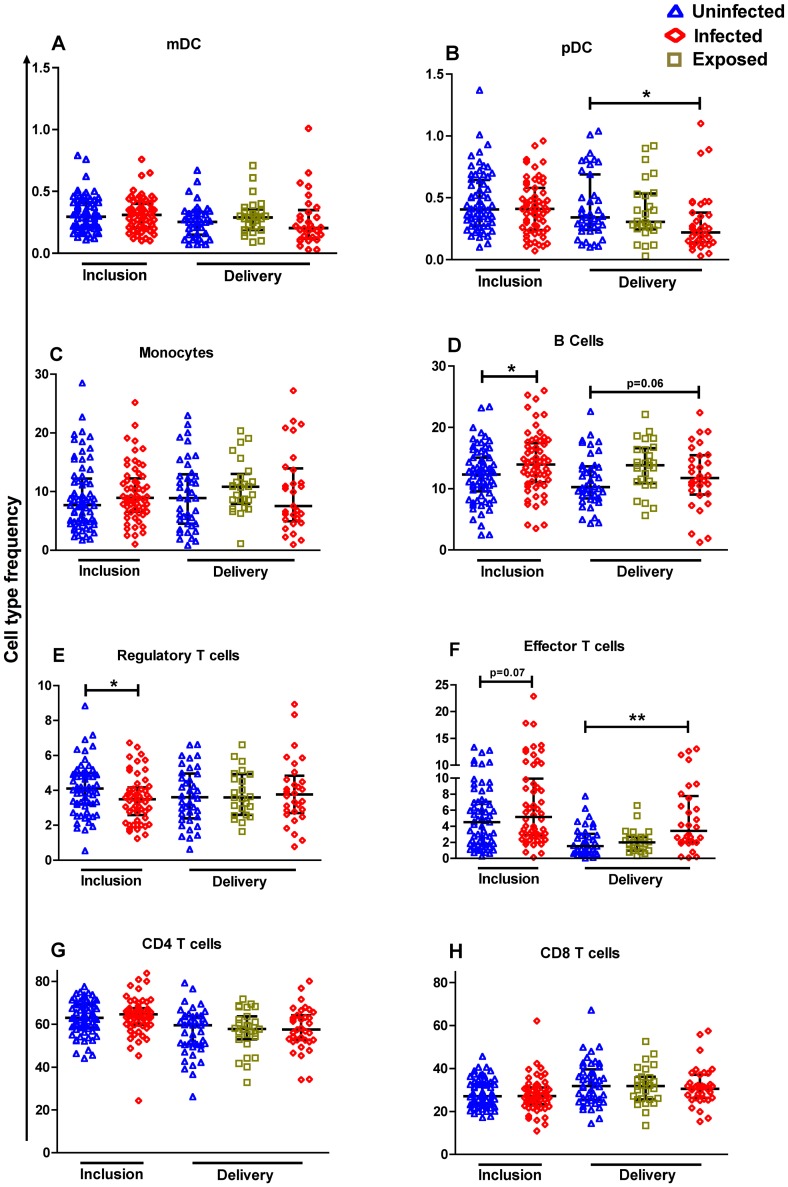

P. falciparum infection-related changes in peripheral blood mononuclear cell frequencies of pregnant Beninese at inclusion and at delivery.Scatter plots include bars depicting medians with interquartile ranges of antigen-presenting cells (A, B, C and D) and T cell subset frequencies (E, F, G and H) from 69 uninfected compared to 62 infected women at inclusion, and from 47 uninfected, 27 exposed and 37 infected women at delivery. The statistical significance of differences between profiles segregated according to the presence or absence of infection were determined using the non-parametric Mann Whitney U test for data at inclusion combined with the non-parametric Kruskall Wallis test for data at delivery. *p<0.05, **p<0.01.